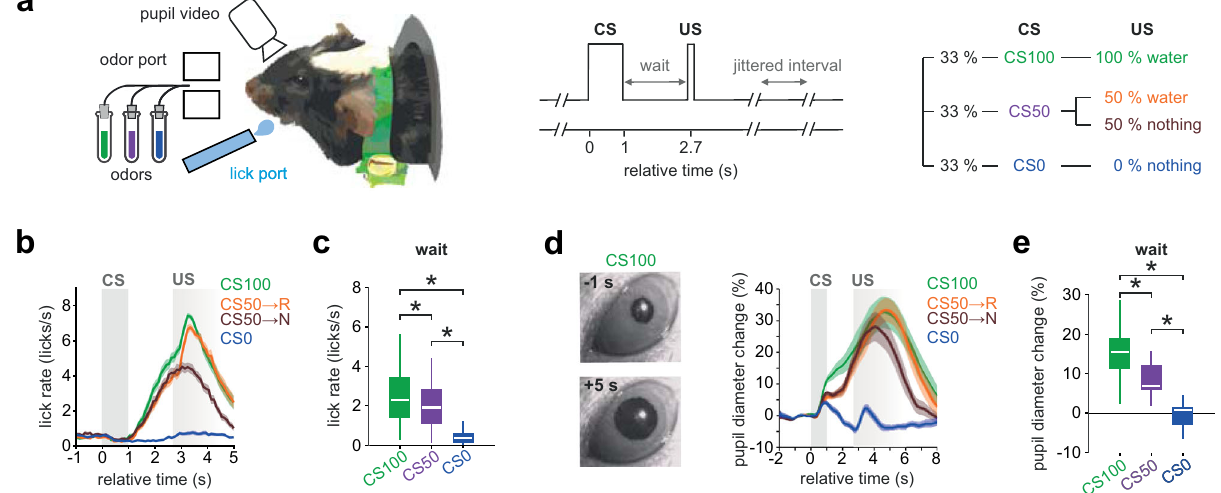
Fig. 1 Trained mice display differential anticipatory responses to olfactory stimulus-outcome pairs. a Mice were trained to learn stimulus-outcome pairs: Three different odors (CS) were applied for 1 s followed by a fi xed waiting period of 1.7 s before a drop of water was delivered (US). Licking behavior and pupil diameter were monitored simultaneously. Stimulus CS100 and CS50 predicted US with different reward probabilities (100% and 50%). Stimulus CS0 was never rewarded. The time interval between CS onsets of consecutive trials (trial duration) was jittered between 10 and 12 s. b Evolution of average lick rates ± SEM differentiated trial types ( n = 69 training sessions in 23 animals, 3 sessions per animal). c Lick rate in the waiting window differentiated the respective trial types with CS100 > CS50 > CS0 ( n = 69 training sessions in 23 animals; one-way ANOVA with Tukey post hoc comparisons). d Video frames illustrating pupil images 1 s before and 5 s after the onset of CS100 (left). Average change ± SEM of the baseline subtracted pupil diameter also differentiated trial types (right; n = 10 sessions in ten animals). e In the waiting period, average (±SEM) percentage change of pupil diameter revealed a similar pattern as licking ( n = 10 sessions in ten animals; one-way ANOVA with Tukey post hoc comparisons). In the fi gure: * indicates P < 0.05 (see Supplementary Table 1 for exact P values and test details). Box plots: The bounds of the box represent 25th to 75th percentiles. The center indicates the median. The lower and upper whiskers represent the minimum and maximum values. Source data are provided as a Source Data fi le.